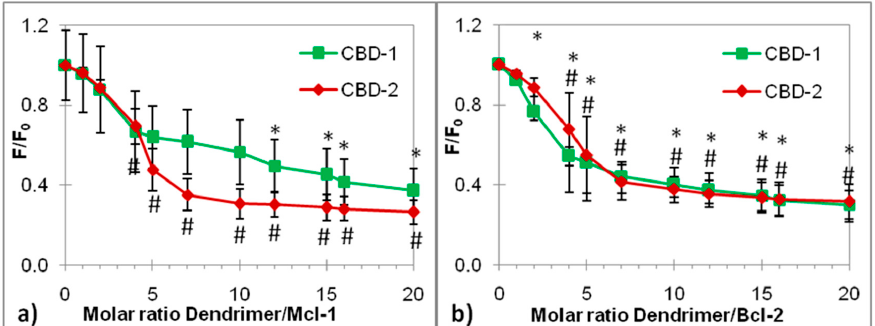
Figure 5. Dependence of the fluorescence intensity of the EtBr-siRNA complex on an increasing concentration of CBD-1 and CBD-2 dendrimers. (a) Mcl-1; (b) Bcl-2. siRNA concentration, 0.5 μ M; EtBr concentration, 5 μ M. Na-phosphate buffer, 10 mmol/L, pH 7.4. λ ex = 480 nm, λ em = 525–650 nm. Results are presented as mean ± SD obtained from a minimum of 3 independent experiments. * p < 0.05 compared to siRNA (after addition of CBD-1); # p < 0.05 compared to siRNA (after addition of CBD-2).